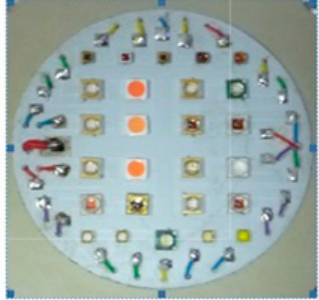
Figure 5. The view of the LED matrix.